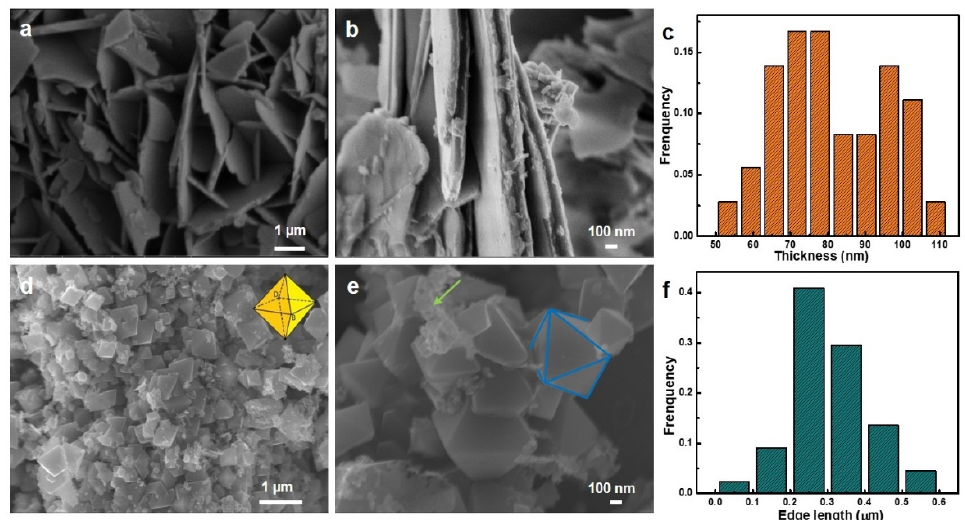
Figure 3. SEM images showing the morphology of products obtained by the dealloying Al 98 Fe 2 ribbons in the ( a , b ) 2 and ( d , e ) 5 M NaOH solutions. The columnar plots showing the ( c ) thickness distribution of the FeAl-LDH nanosheets and the ( f ) edge length distribution of Fe 3 O 4 nanooctahedrons, respectively.